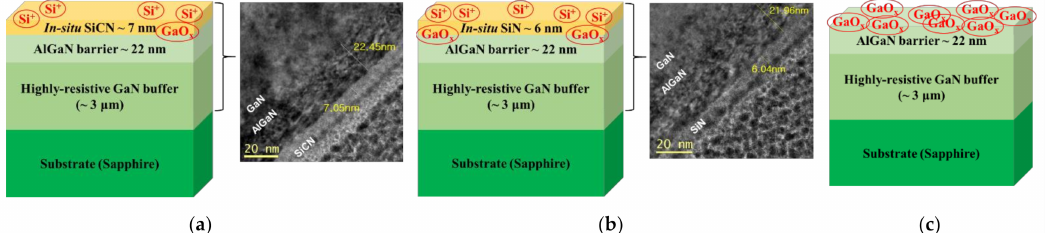
Figure 1. Schematic illustrations of the epitaxial structure and configuration for the fabricated devices and TEM images of ( a ) SiCN/AlGaN/GaN and ( b ) SiN/AlGaN/GaN heterostructure grown on sapphire substrate. Schematic image of ( c ) shows the reference device without in situ cap layer. The device with SiN cap layer contains many positive ionic charges (Si + and GaO x ), while the SiCN capped device has less positive ionic charges during the epitaxial growth. On the other hand, the reference device without in situ cap layers contains lots of the natural oxide (GaO x ) on the AlGaN